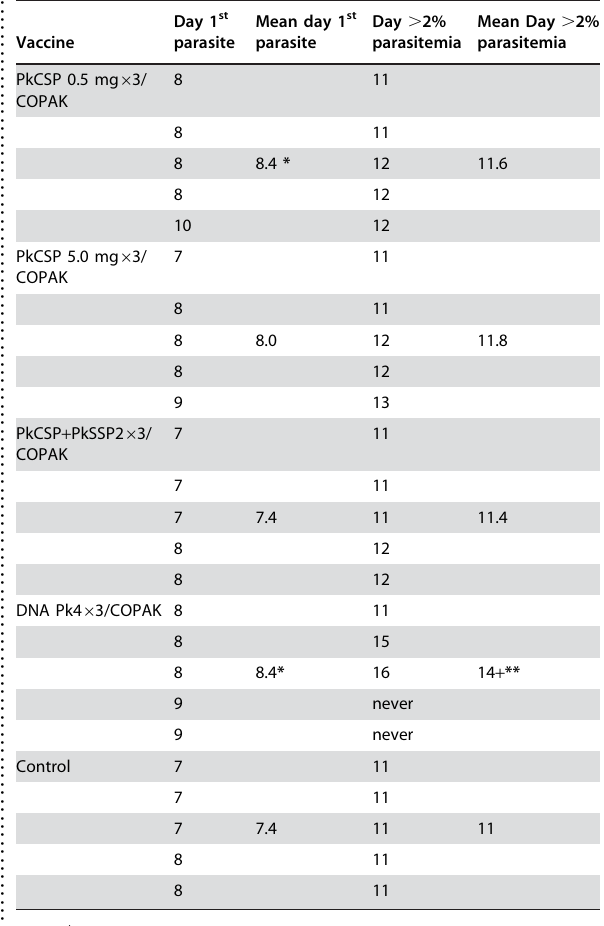
Table 4. Summary of parasitemia data in Experiment # 2 .. ... .... ... ... .... ... ... .... ... ... .... ... ... .... ... ... .... ... ... .... .